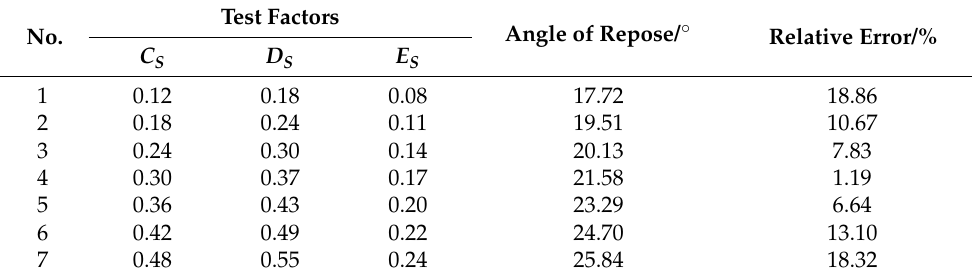
Table 8. Scheme and results of the steepest ascent